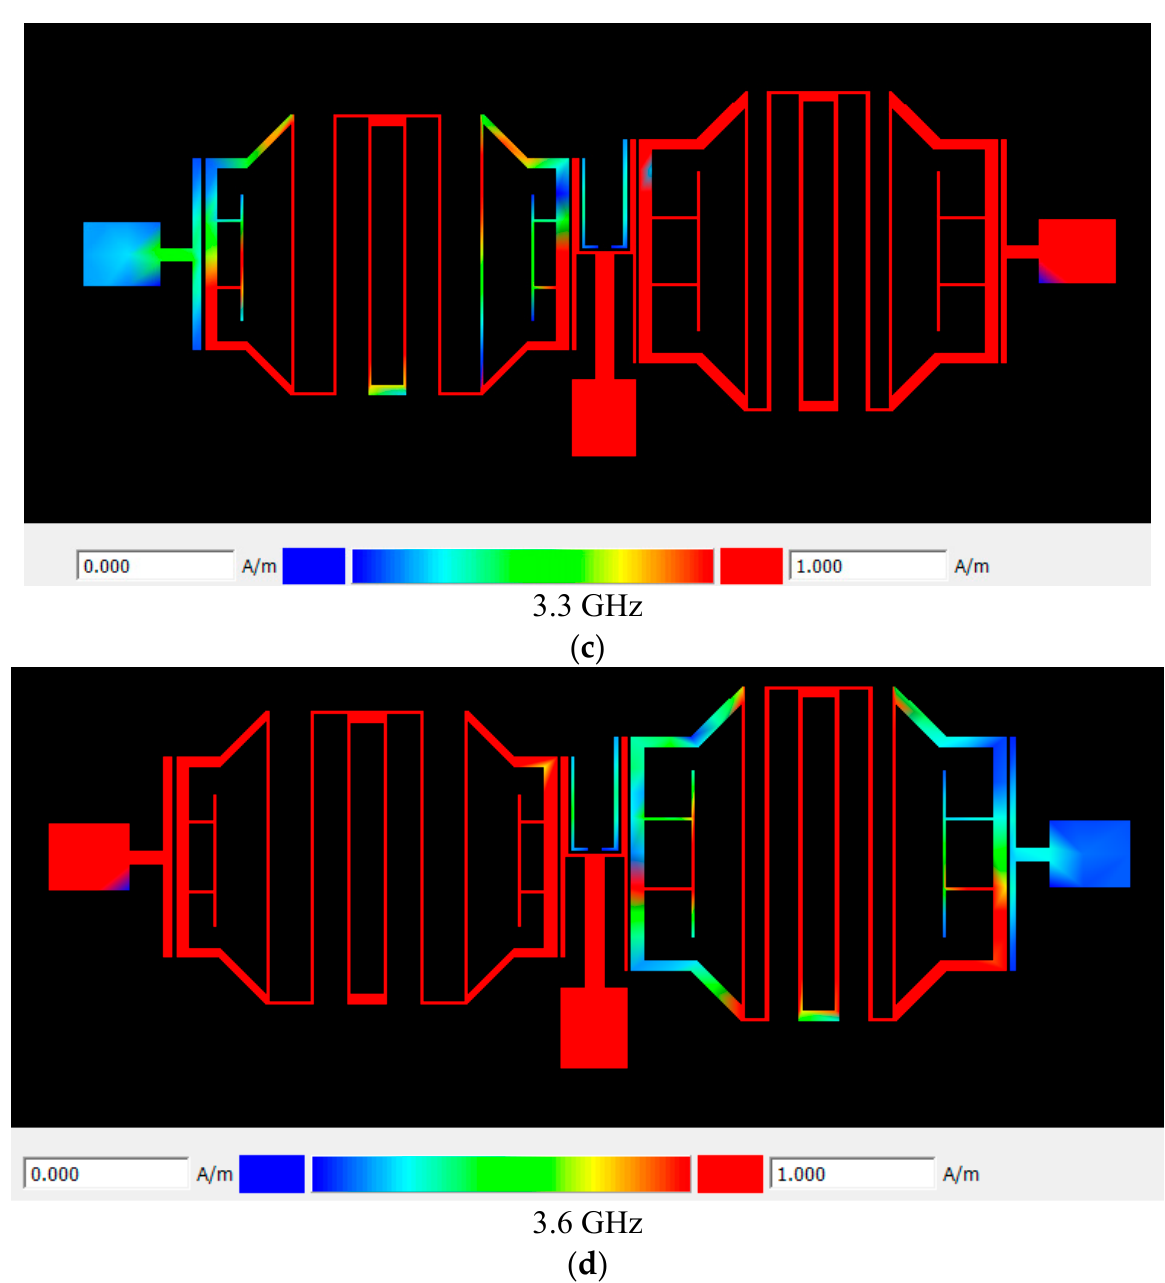
Figure 15. Surface current distribution in the proposed diplexer at the frequencies of: ( a ) 1.7 GHz, first frequency band in port2; ( b ) 1.9 GHz, second frequency band in port3; ( c ) 3.3 GHz, third frequency band in port2; and ( d ) 3.6 GHz, fourth frequency band in port3. The maximum value of magnetic intensity is 1 A/M in all of cases.